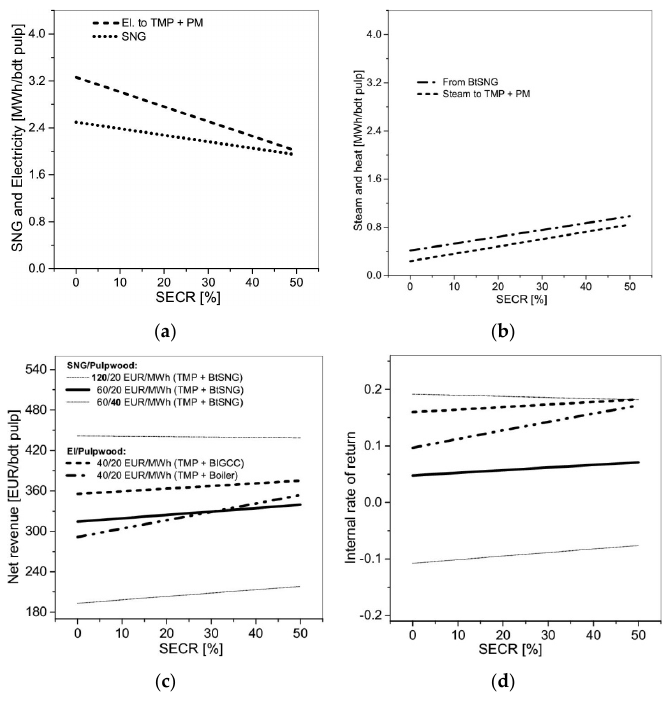
Figure 8. Effect of reducing the TMP specific electricity consumption.